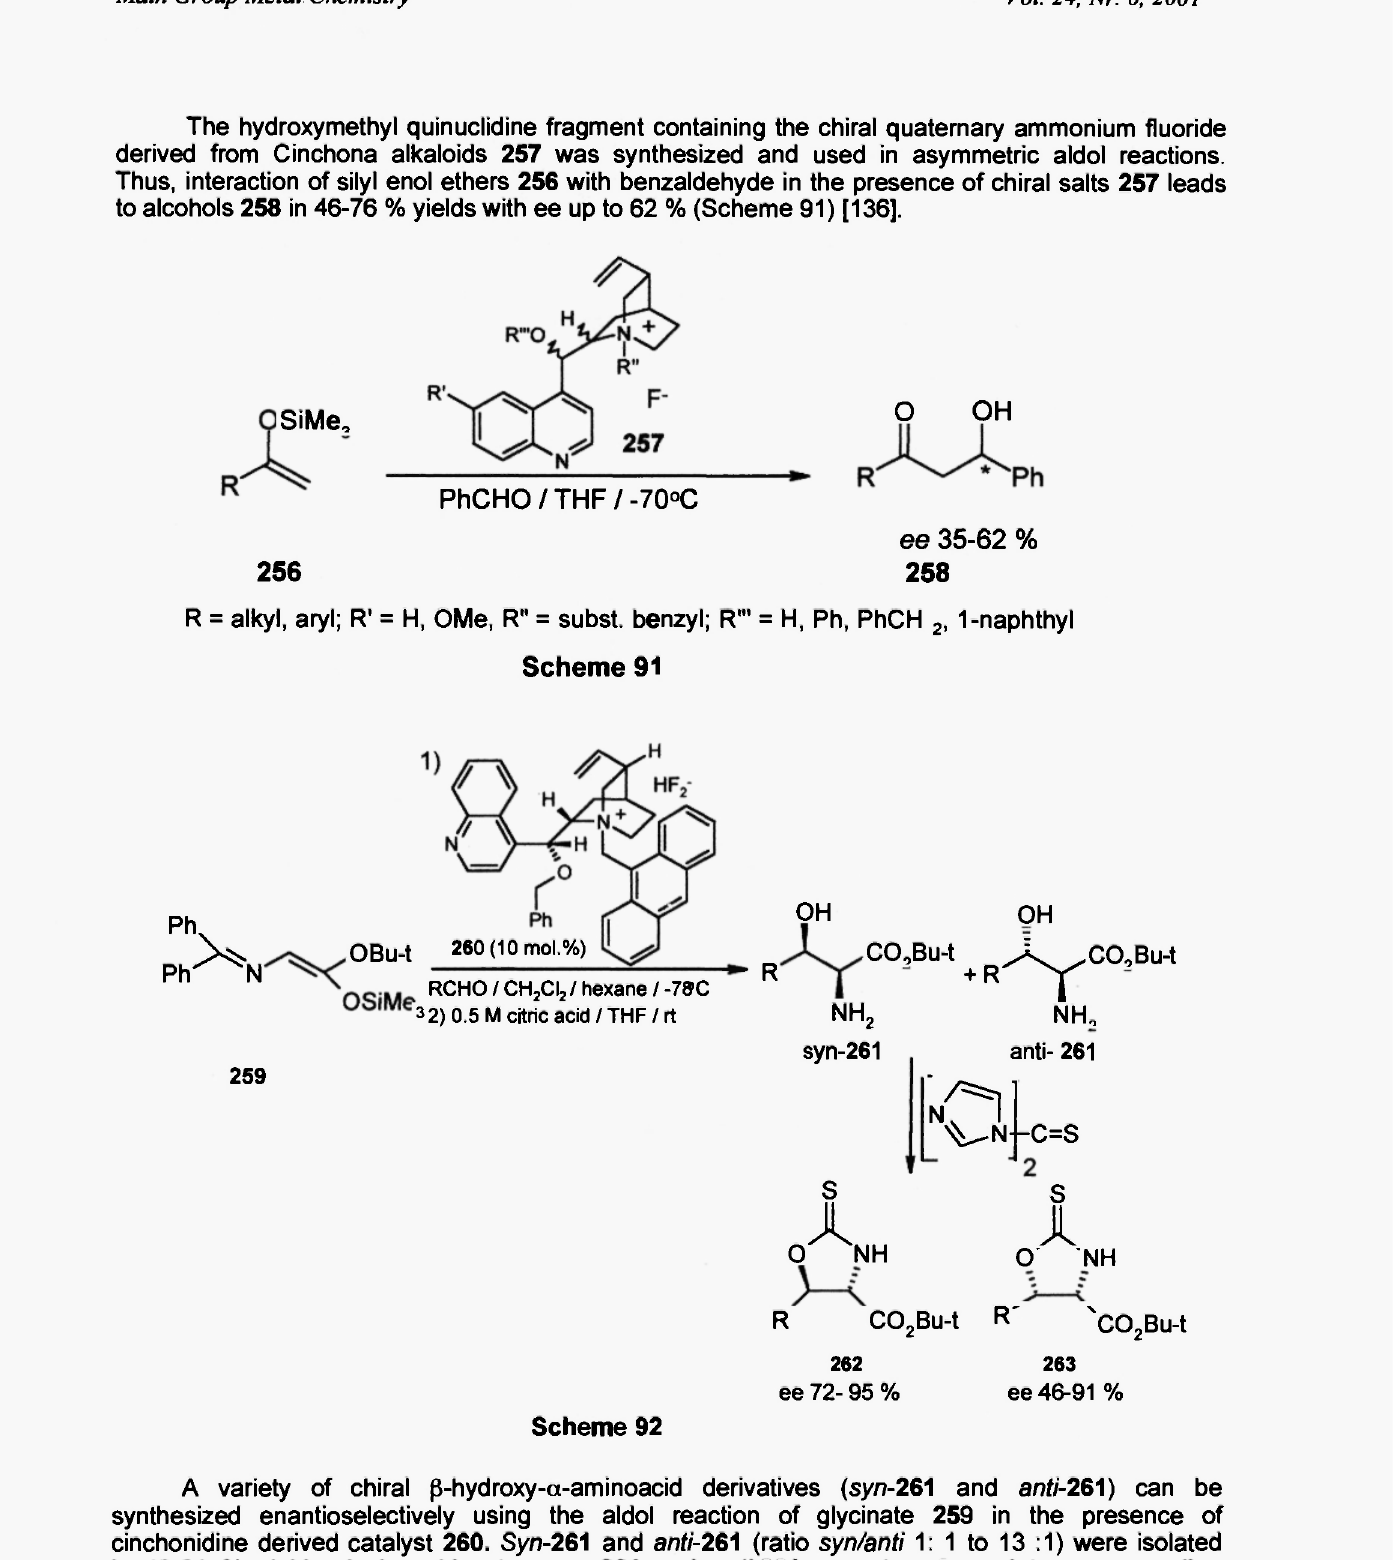
The hydroxymethyl quinuclidine fragment containing the chiral quaternary ammonium fluoride derived from Cinchona alkaloids 257 was synthesized and used in asymmetric aldol reactions. Thus, interaction of silyl enol ethers 256 with benzaldehyde in the presence of chiral salts 257 leads